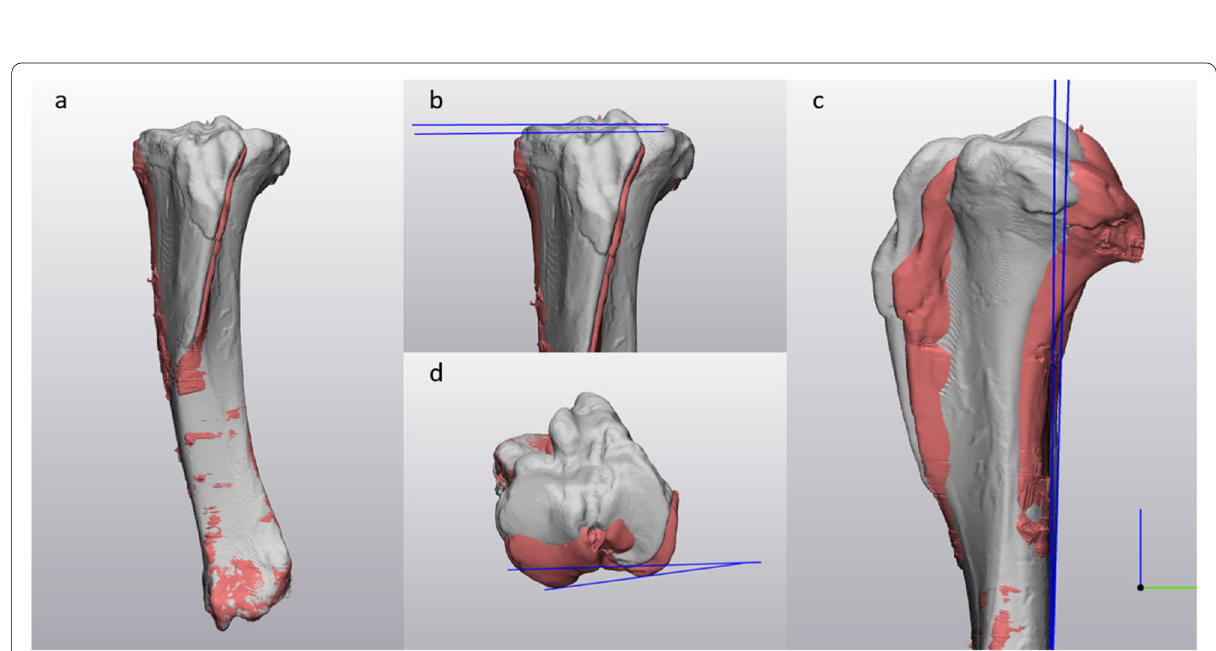
Fig. 8 Comparison of postoperative result to the preoperative plan of the tibia with Materialise 3-matic software. Each picture shows two porcine tibial bone models. The preoperative model is grey while the achieved result is green. Both models were fitted distally (automatic registration, a ). Subsequently, the measurements of varus/valgus ( b ), procurvatum/recurvatum ( c ) as well as rotation ( d ) were performed proximally. The blue lines indicate a tangent to each of the bone at defined points. For varus/valgus and rotation a tangent to the most proximal point of the medial and lateral tibial plateau was drawn. For procurvatum/recurvatum, the tangent was fitted to the posterior tibial cortex on a lateral view. The angle between these lines represents the respective deviation from the